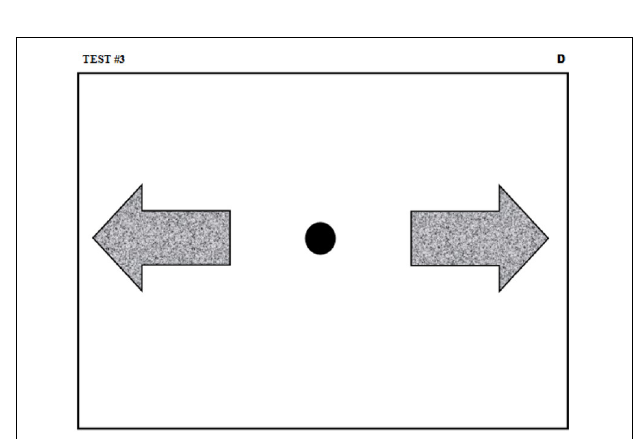
subjects. Left-handed subjects are given identical guiding sheets except that they are mirror reflected with respect to a vertical symmetry axis, as shown in (B) .